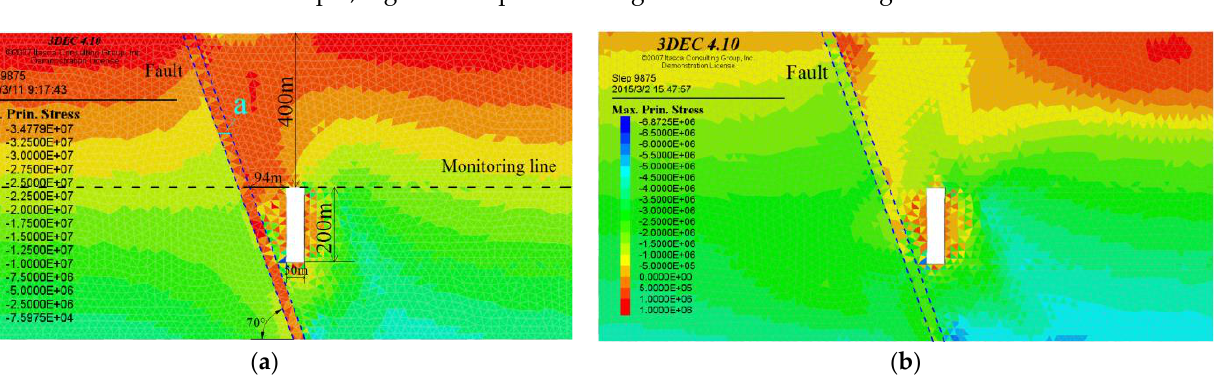
Figure 22. The principal stress distribution of surrounding rock when the thickness of the fault zone is 30 m, they should be listed as: ( a ) Maximum principal stress distribution; ( b ) Minimum principal stress distribution.